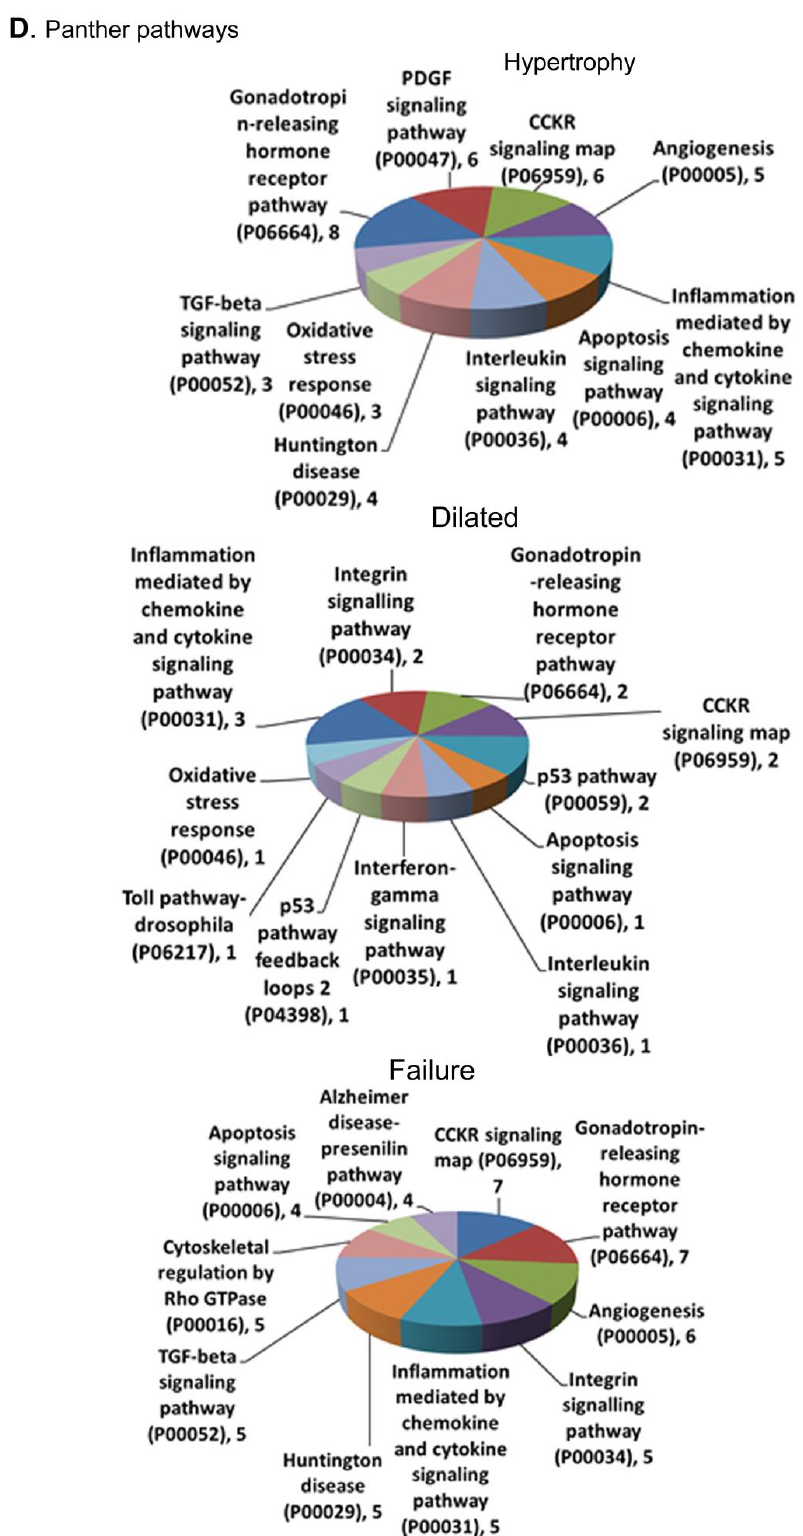
Figure 4. The PANTHER analysis of DEGs for functional annotation. The DEGs of each pathological stage were analysed for molecular function (MF), biological process (BP), cellular component (CC), protein classification (PC), and PANTHER pathways. Representation of the enrichment of each GO term by DEGs of ( A ) hypertrophy stage, ( B ) dilated stage, and ( C ) failure stage. ( D ) The significant PANTHER pathways enriched by DEGs of hypertrophy, dilated, or failure